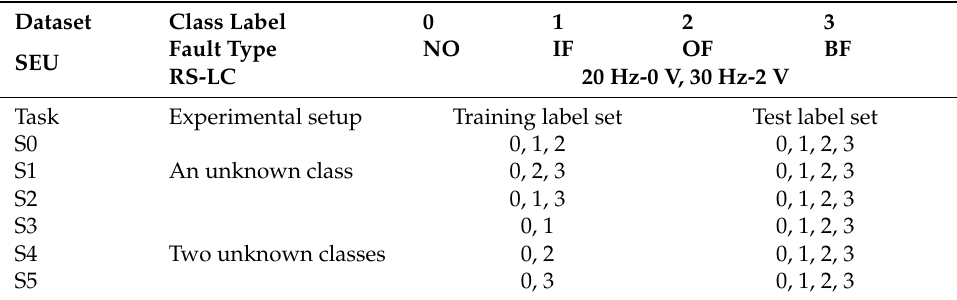
Table 4. The information of the SEU and specific task settings.